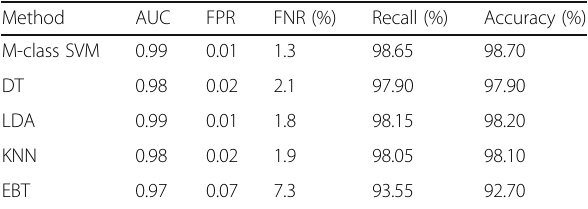
Table 5 Results of proposed algorithm compared using